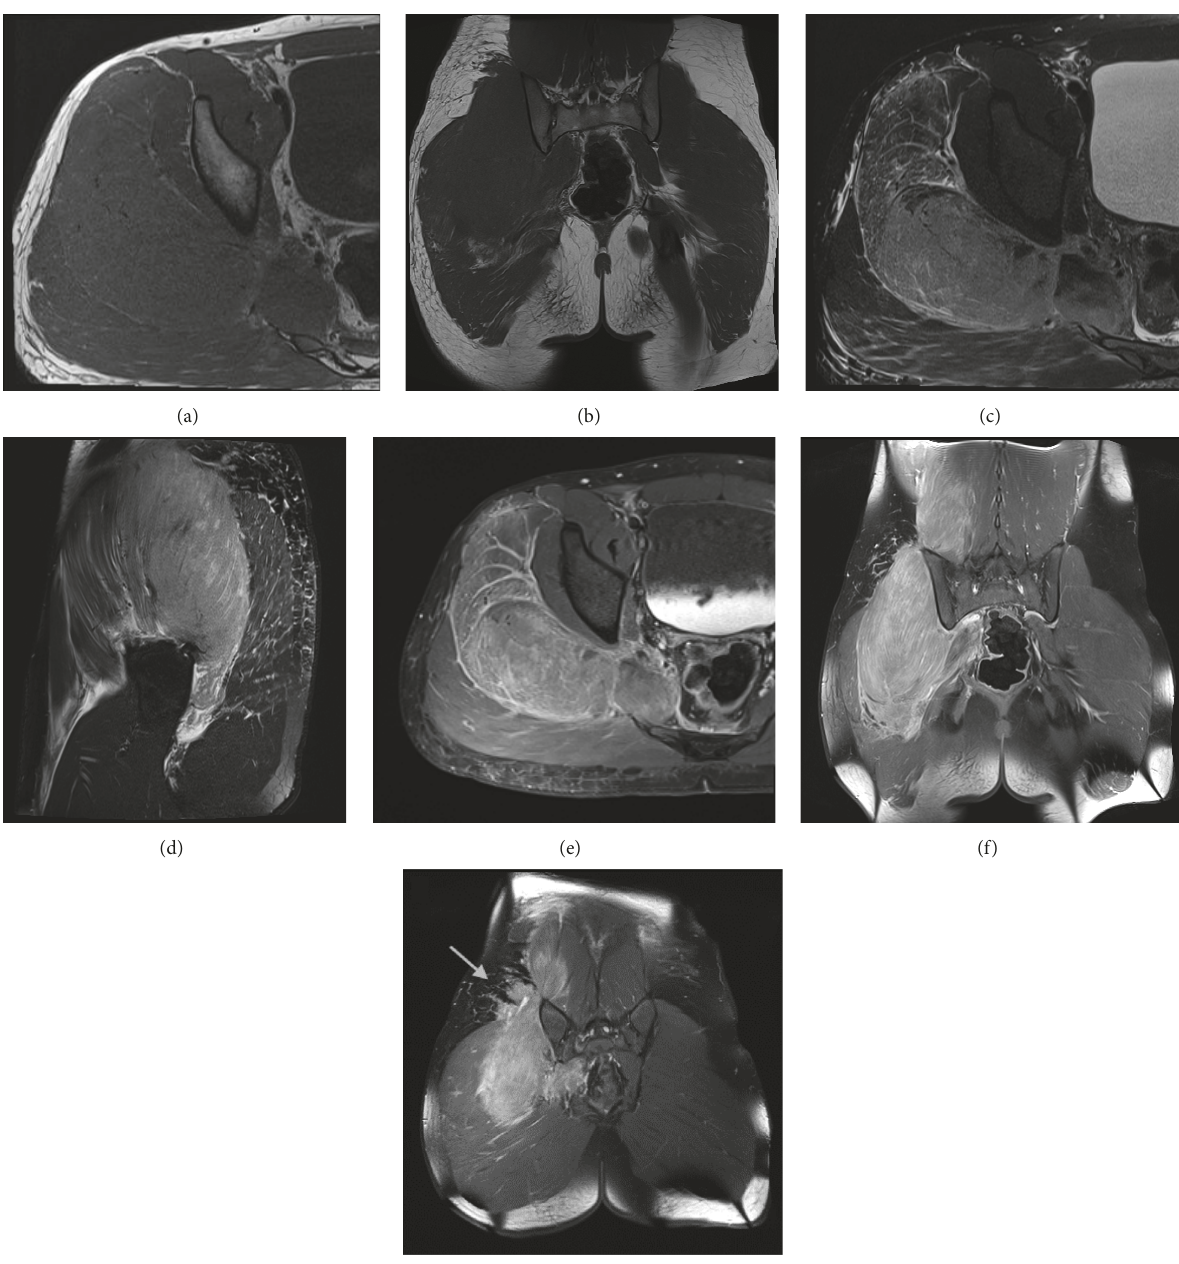
Figure 1: Axial T1 (a), coronal T1 (b), axial T2 (c), sagittal T2 (d), axial T1 FS postcontrast (e), coronal T1 FS postcontrast (f), and coronal T1 FS postcontrast (g) images of the involved lumbar spine and pelvis in the 17-year-old boy from case 1. There is unilateral marked expansion of the right gluteal, piriformis, and paraspinal muscles, exhibiting T1 isointensity and T2 hyperintensity. The muscle enlargement results in effacement of intramuscular fat. The postcontrast images demonstrate diffuse striated enhancement, giving an infiltrative appearance. Enhancing nodules are seen in the adjacent subcutaneous tissues. There is also subcutaneous fat stranding (indicated by the arrow, image (g)). Aside for the enlargement, note the overall preservation of muscle morphology and lack of a focal